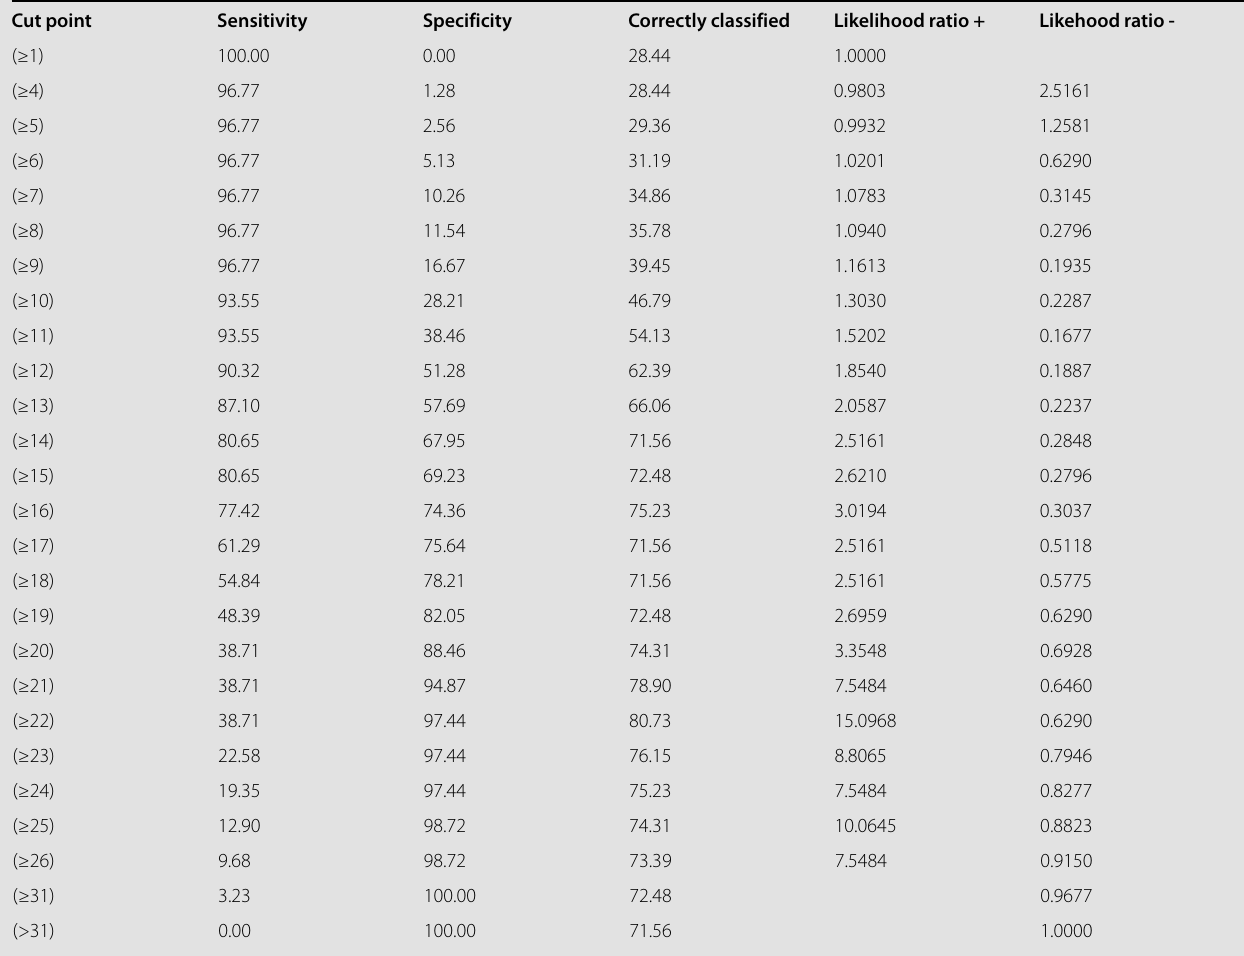
Table 4. Cut-points of BDI and corresponding sensitivity and specificity to predict suicidal ideation 6 weeks after HIV diagnosis Cut point